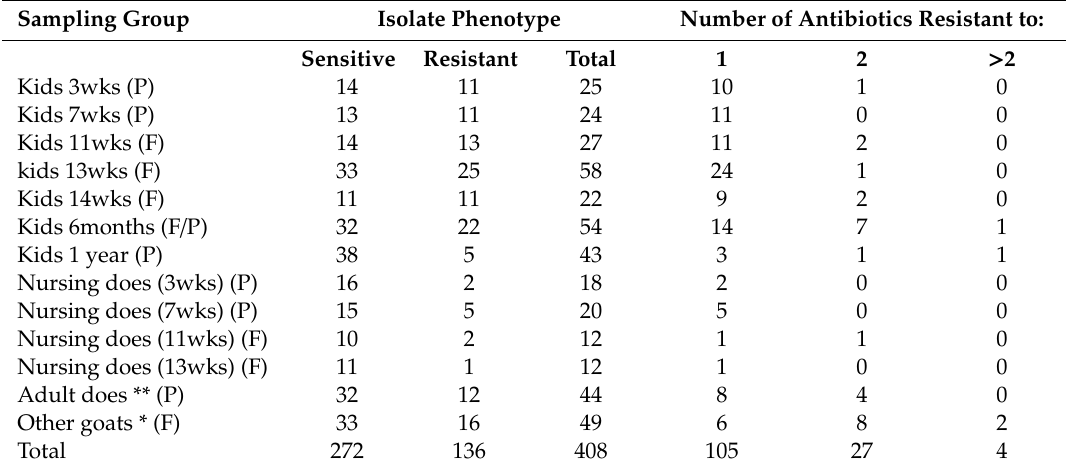
Table 3. Animal groups sampled and resistance phenotypes detected in 408 E. coli isolates from pastured meat goats.